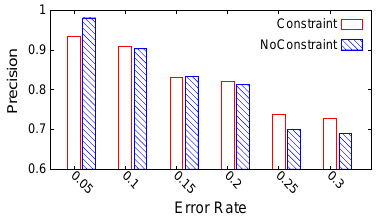
Figure 10. Relationship between error rate and